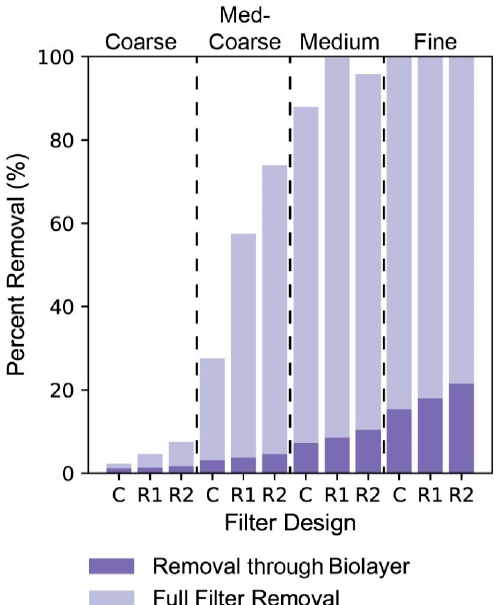
Figure 9. Modeled percent removal of MS2 at the biolayer and at the full filter length for a traditional BSF design (C), a 40% reduced-height design (R1), and a 70% reduced-height design (R2).